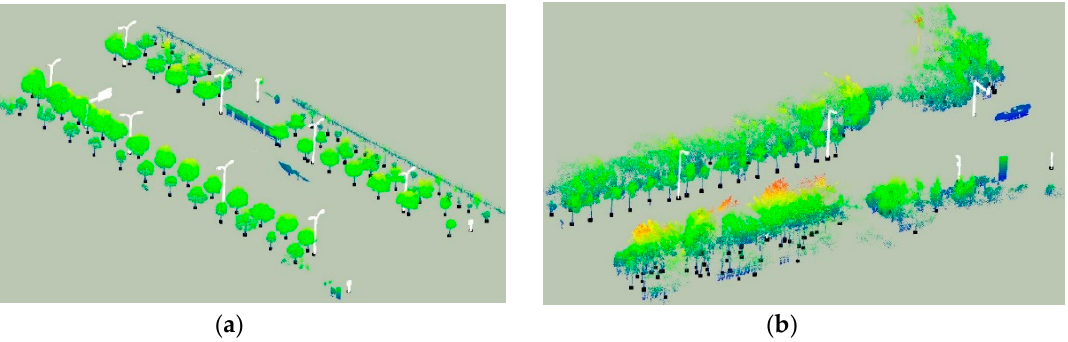
Figure 11. Result samples of detected road poles in two selected scenes.